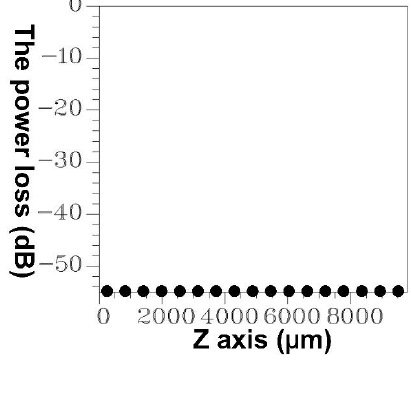
Figure 9. The relationships between the propagation length and the power loss for 50 guided